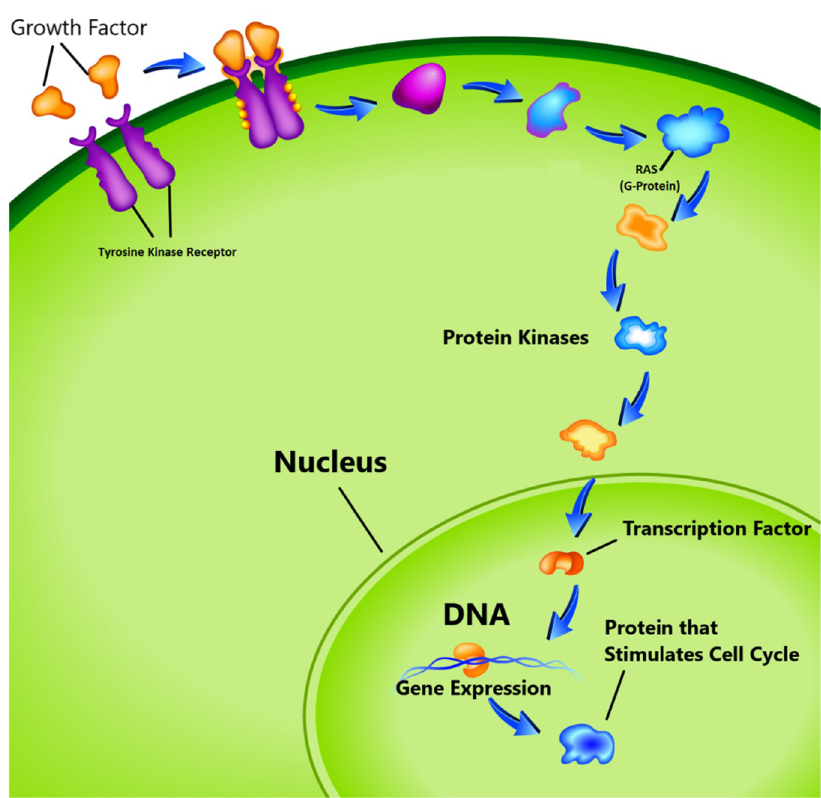
Figure 1. Cell cycle proliferation. (image courtesy: AtheroPoint TM , Roseville, CA, USA) . Table 1. Genomics relevance with Brain Tumor, RKT: Receptor Tyrosine Kinase, TP53 (p53): Tumor Protein53, RB1: Retino Blastoma1, EGFR: Epidermal Growth Factor Receptor, PTEN: Phosphatase and Tensin Homolog, IDH1/DH2: Isocitrate Dehydrogenase 1/2, 1p and 19 co-deletion, MGMT: O6-methylguanine DNA methyltransferase, BRAF: B-Raf